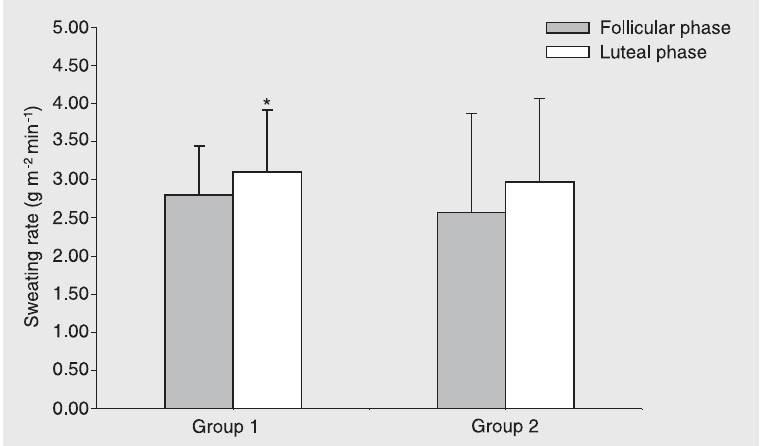
Figure 2. Sweating rate during the exercise performed in different phases of the menstrual cycle. Group 1 showed serum progesterone and basal temperature elevation in the luteal phase, and group 2 showed no elevations. Data are reported as means ± SD. The sweating rate increased during the luteal phase in comparison to the follicular phase in group 1 (*P < 0.05, Student t